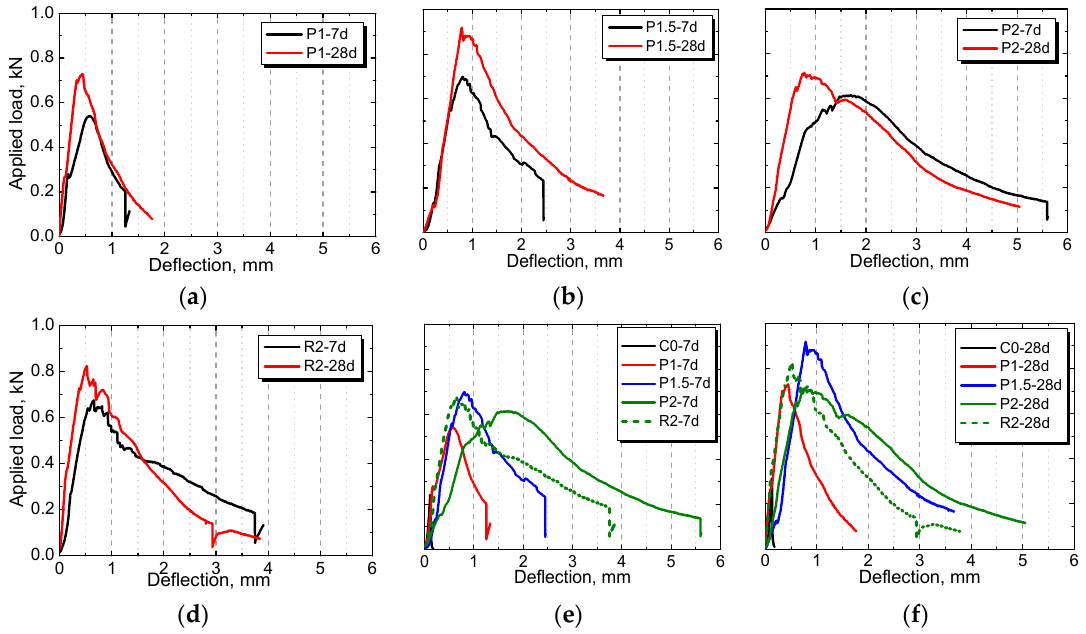
Figure 9. The load–deflection curves of NPFRCCs with different amount of fibers (( a ) P1, (b) P1.5, ( c ) P2 and ( d ) R2) and the comparison at ( e ) seven days and ( f ) 28 days based on the three-point (3-P bending test.